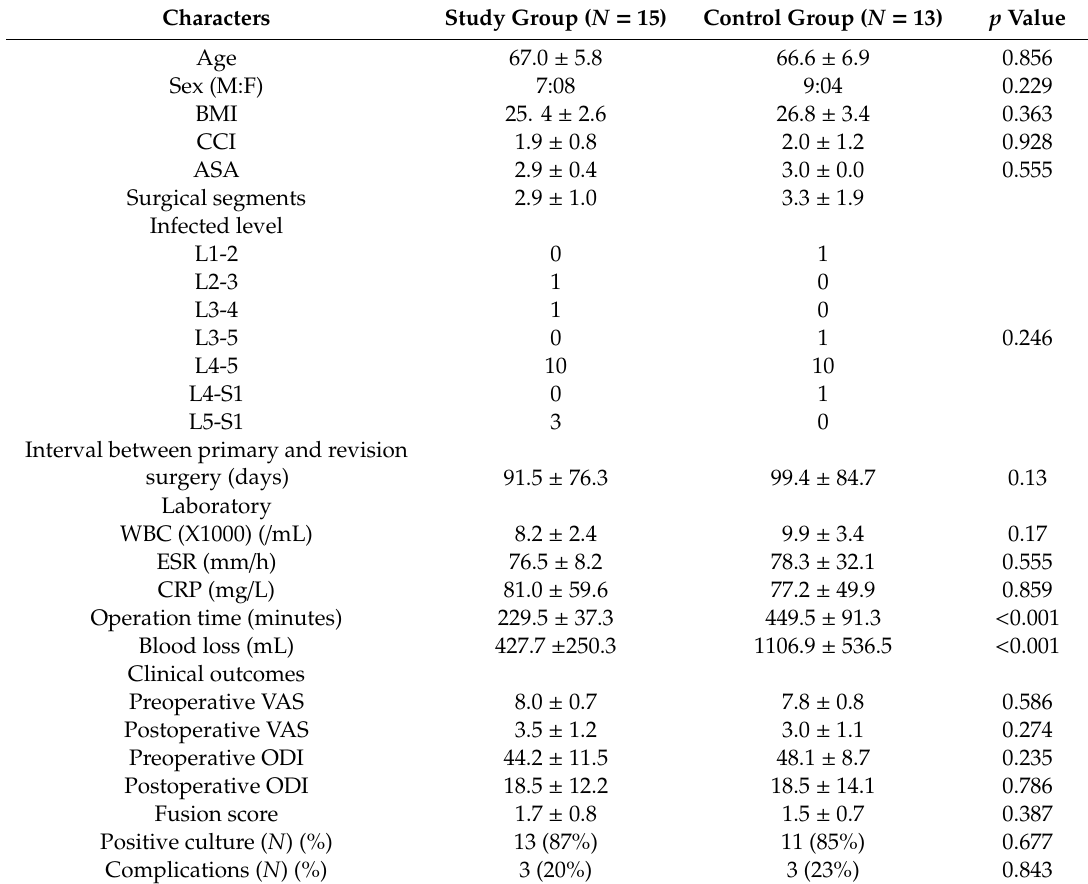
Table 2. Comparisons between the study and the control